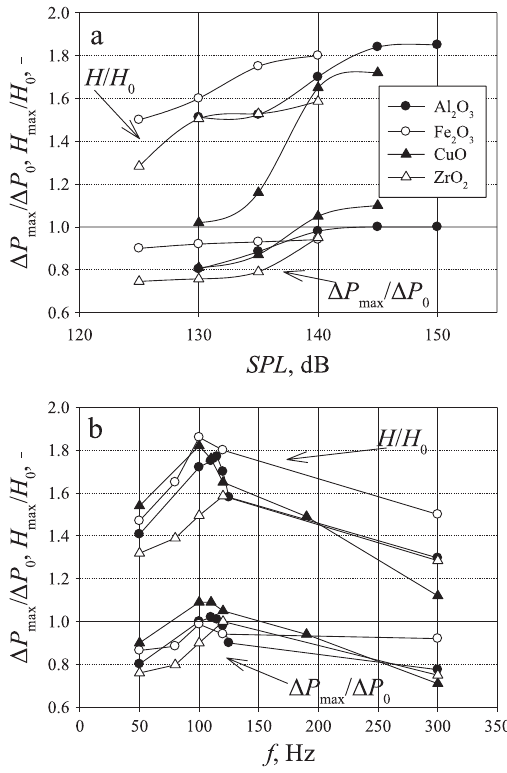
Fig. 3 (a) Effect of SPL ( f = 120 Hz) and (b) effect of sound frequency ( SPL = 140 dB) on Δ P max /Δ P 0 , H mf / H 0 for all the